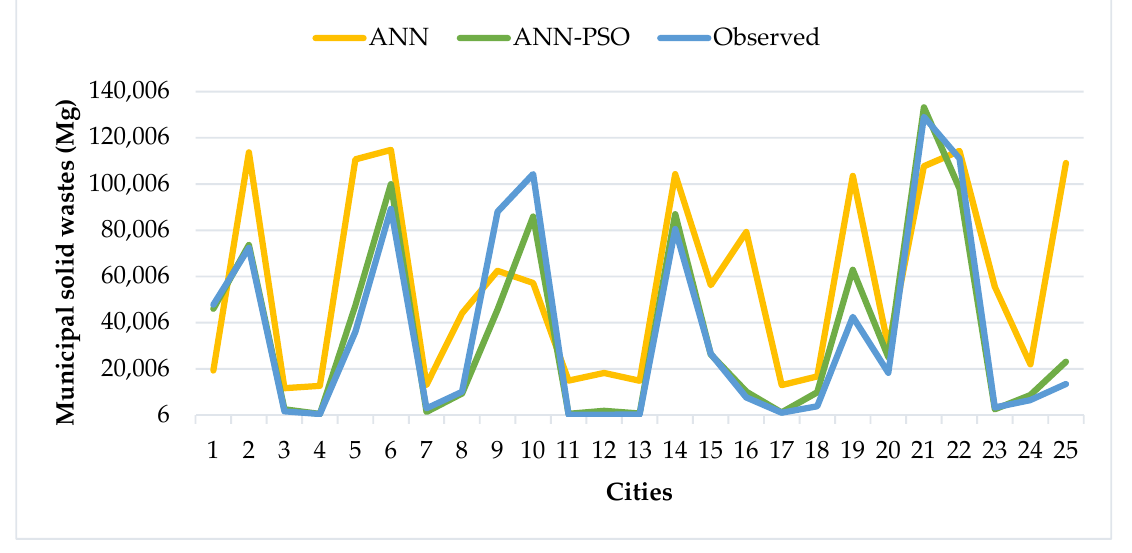
Figure 7. Time series plot of the actual and predicted MSW. Table 3. Assessment performance metrics of the neural network models.